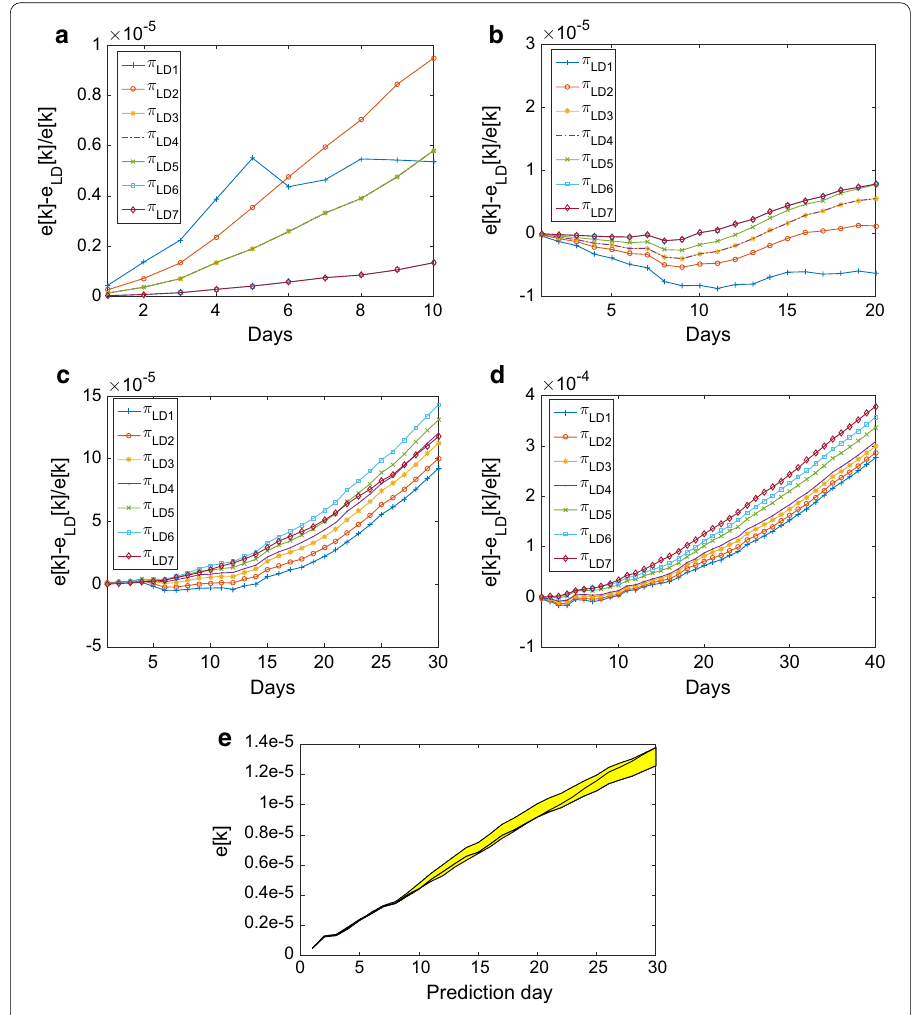
Fig. 2 Mean prediction error when the number of the omitted days equals a n neglect = 10 , b n neglect = 20 , c n neglect = 30 and d n neglect = 40 , for different transmission modifier vectors. e Cone of error evolution for n neglect = 30